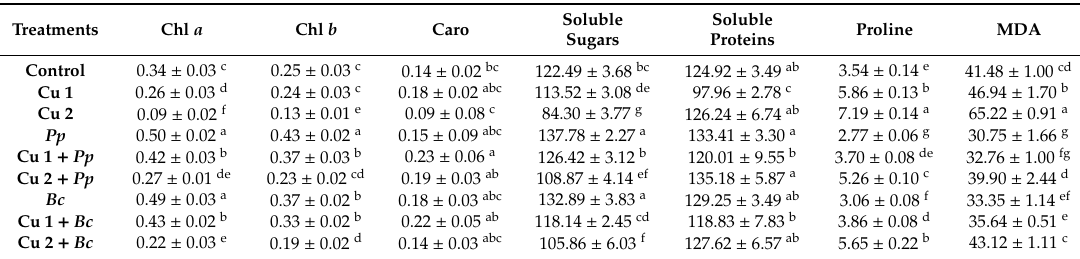
Table 2. E ff ects of bacterial inoculation under copper stress on chlorophyll a (Chl a ), chlorophyll b (Chl b ), carotenoids (Caro), soluble sugars, soluble proteins, proline (mg g − 1 fresh weight (FW)), and malondialdehyde (MDA; nmol g − 1 FW) contents in maize plants. Bars represent the standard deviation ( ± SD) of the means ( n = 3). Di ff erent letters indicate significant di ff erences among the treatments at p < 0.05, according to Duncan’s multiple range test. The treatments include Control, plants without copper stress and bacterial strains inoculation; Cu 1: plants exposed to 100 µ M CuSO 4 ; Cu 2: plants exposed to 500 µ M CuSO 4 ; P. polymyxa ( Pp ) inoculated plants without CuSO 4 ; Cu 1 + Pp : plants exposed to 100 µ M CuSO 4 and inoculated with P. polymyxa ; Cu 2 + Pp : plants exposed to 500 µ M CuSO 4 and inoculated with P. polymyxa ; B. circulans ( Bc ) inoculated plants without CuSO 4 ; Cu 1 + Bc : plants exposed to 100 µ M CuSO 4 and inoculated with B. circulans and Cu 2 + Bc : plants exposed to 500 µ M CuSO 4 and inoculated with B. circulans . Soluble Treatments Chl a Chl b Caro